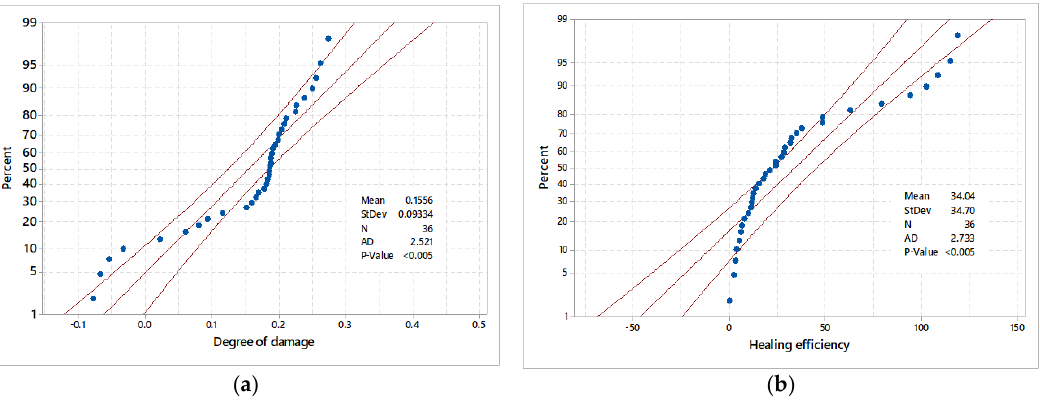
Figure 16. probability plot for output variables ( a ) degree of damage and ( b ) healing efficiency. Figure 16. Probability plot for output variables ( a ) degree of damage and ( b ) healing